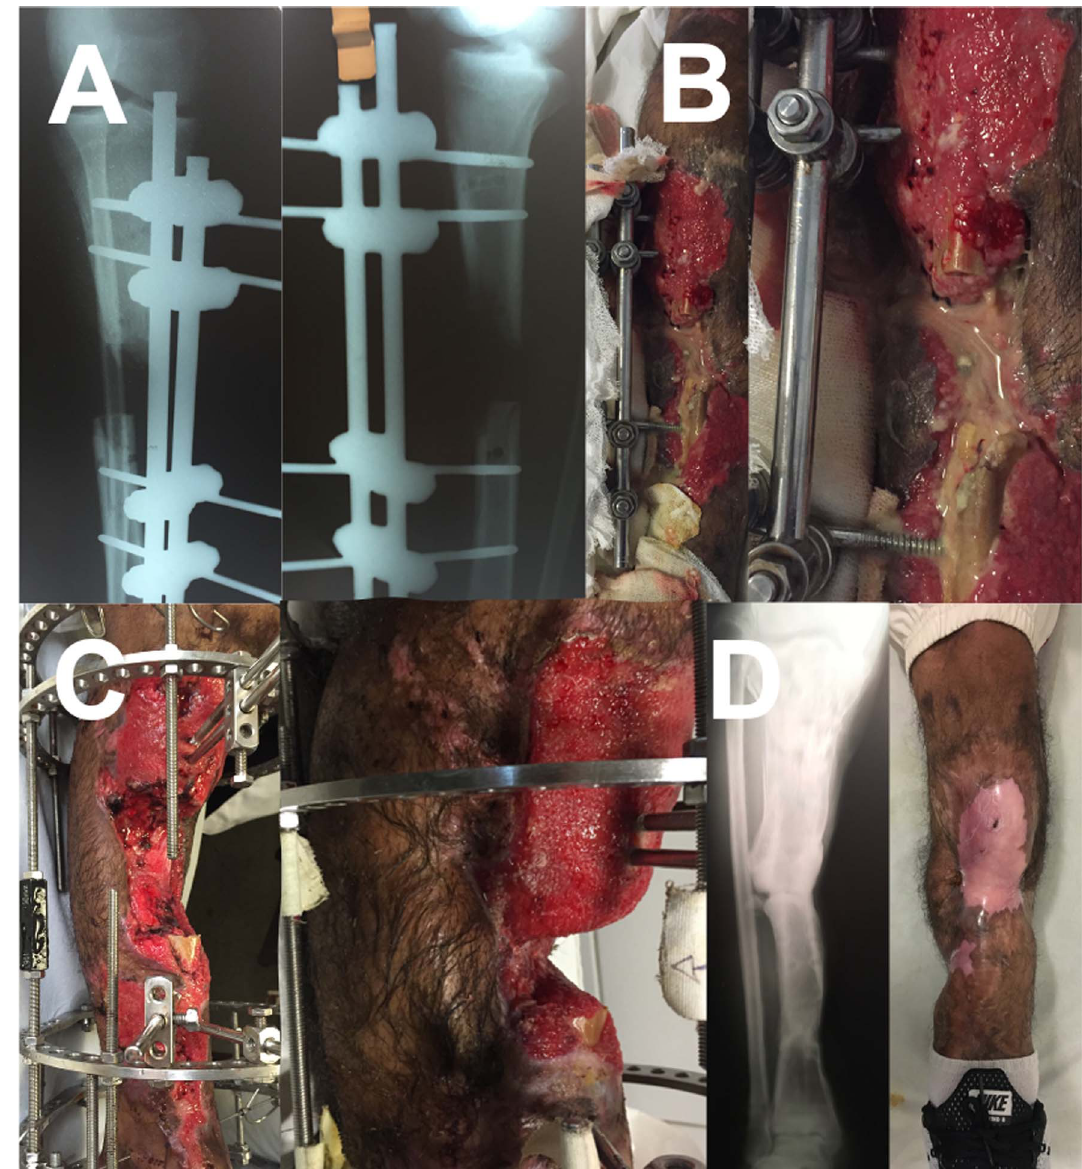
Figure 4. Limb salvage. A grossly infected limb with bone loss (A and B) was salvaged by distraction osteogenesis and transport of the soft tissue envelope with a simple Ilizarov frame (C). Bone healing and no infection were evident at fi nal follow-up